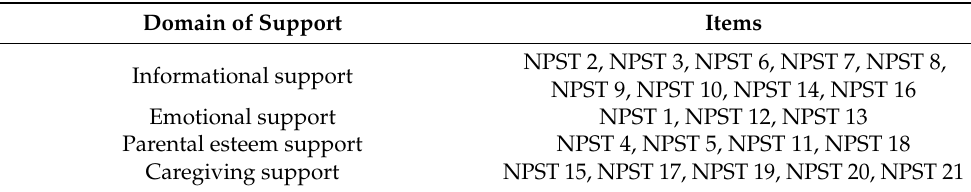
Table 1. Four domains of support assessed by the